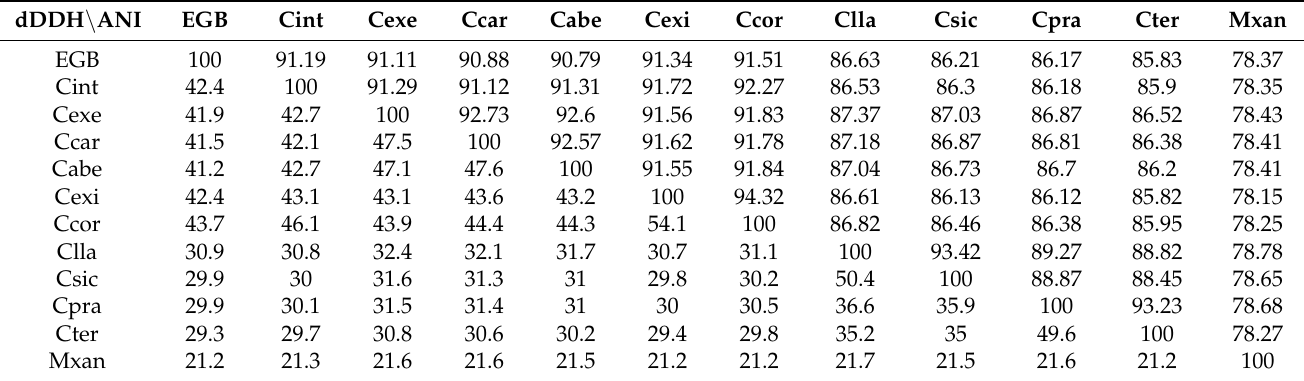
Table 2. ANI and dDDH values for pairwise comparisons between Corallococcus species and M. xanthus